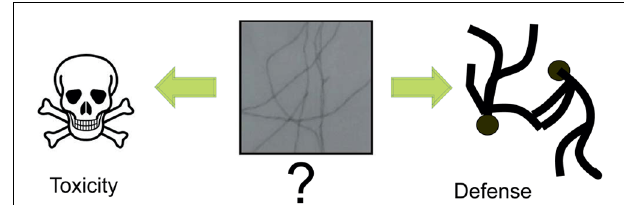
FIGURE 1 | Debated role of fibrillar amyloids. A recurrent question which seems to become clear only recently is whether the fibrillar amyloid species observed in patients’ brains are the toxic species or rather a defense mechanism of the cell.The current view is that the toxic species are the soluble aggregates formed through the aggregation process. As such, the mature fibrillar fibres are the final point of this